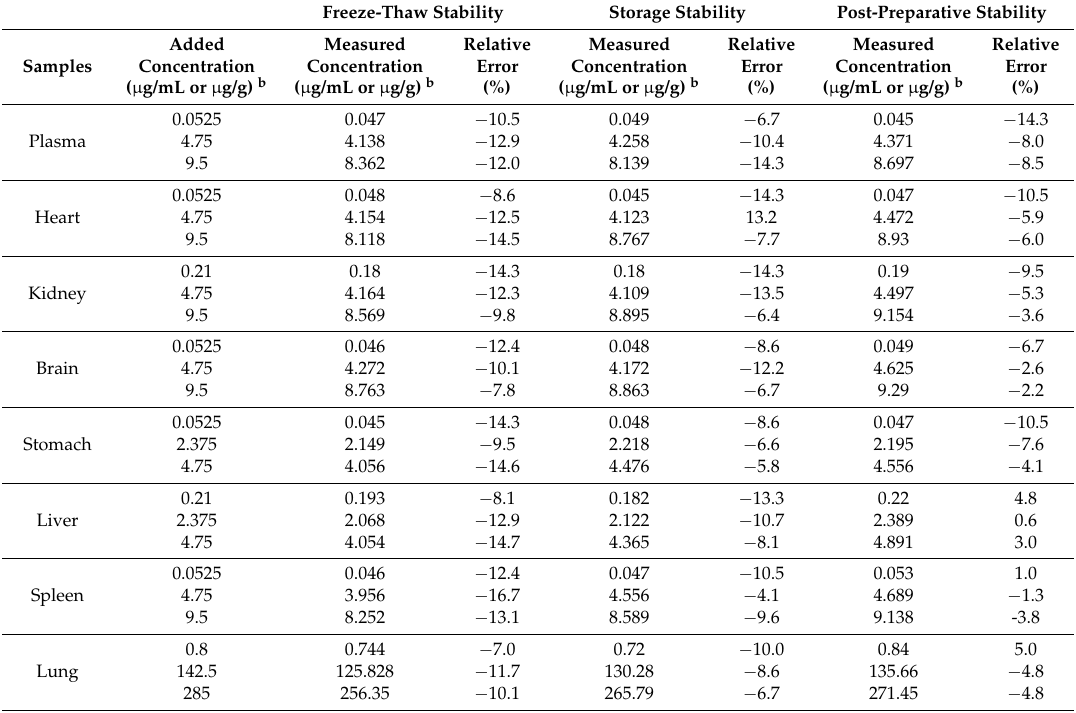
Table 4. Stability of baicalin in rabbit plasma and tissues with QC samples determined by LC-UV a